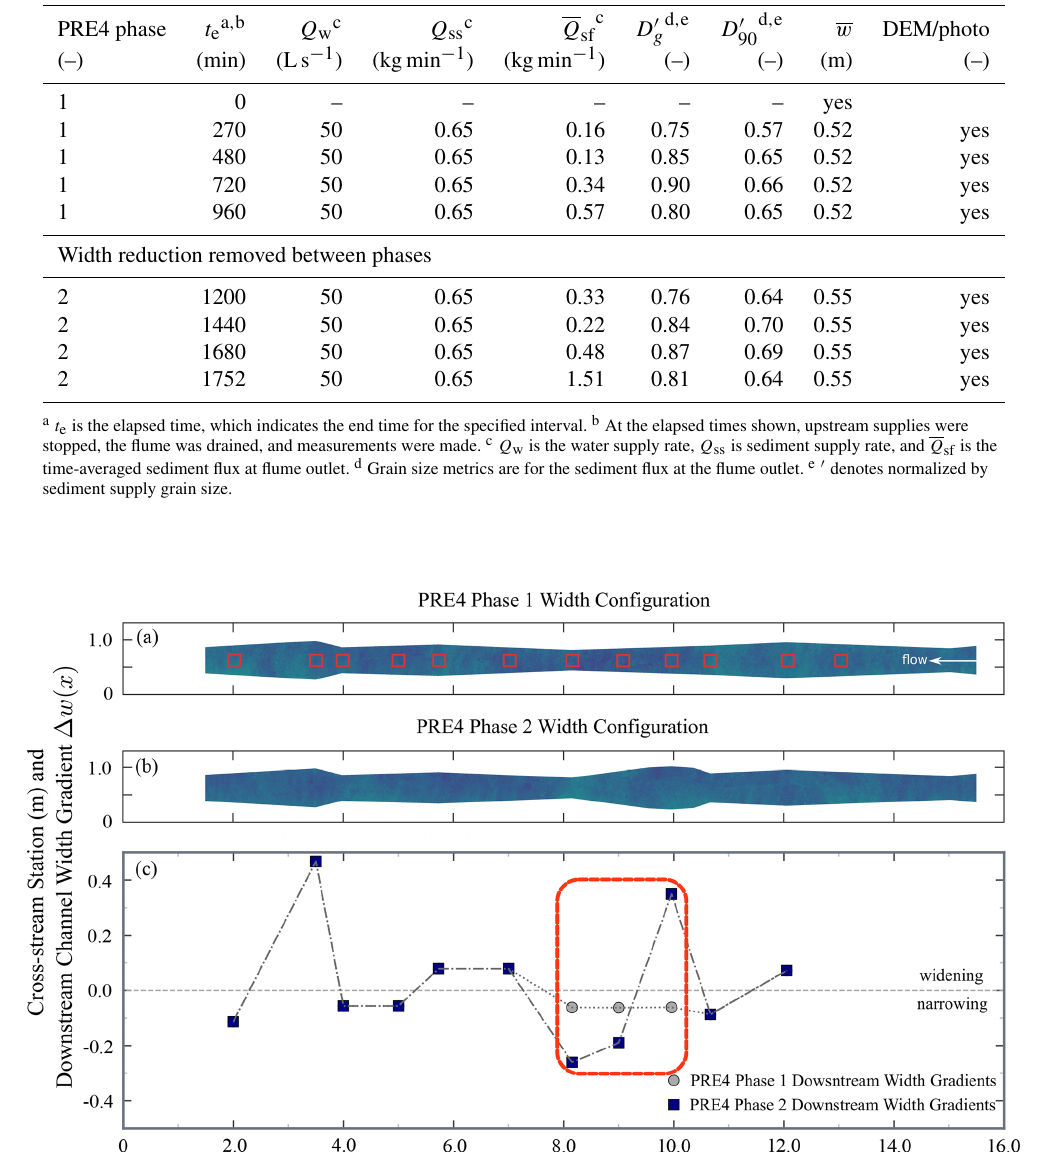
Table 1. Experimental details for PRE4.